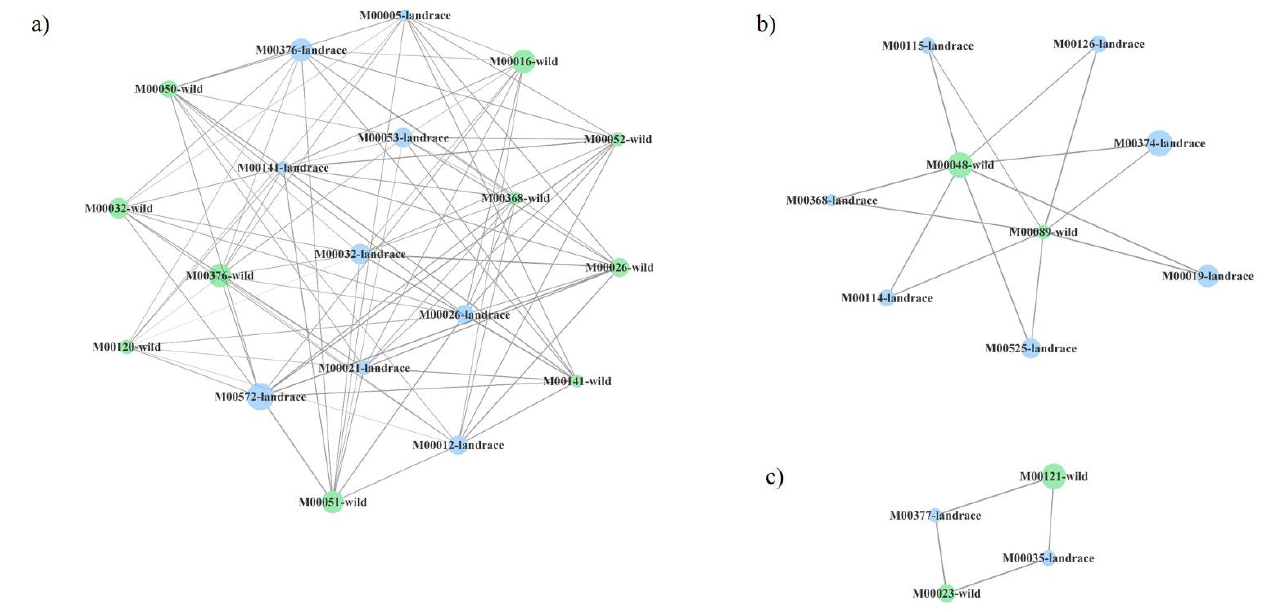
Figure 4. Three ( a – c ) most connected clusters in co-presence networks for the couple tomato landraces (blue):wild tomato related species (green). Node sizes reflect average relative abundance of each KEGG module. The line thickness is proportional to the edge weight.